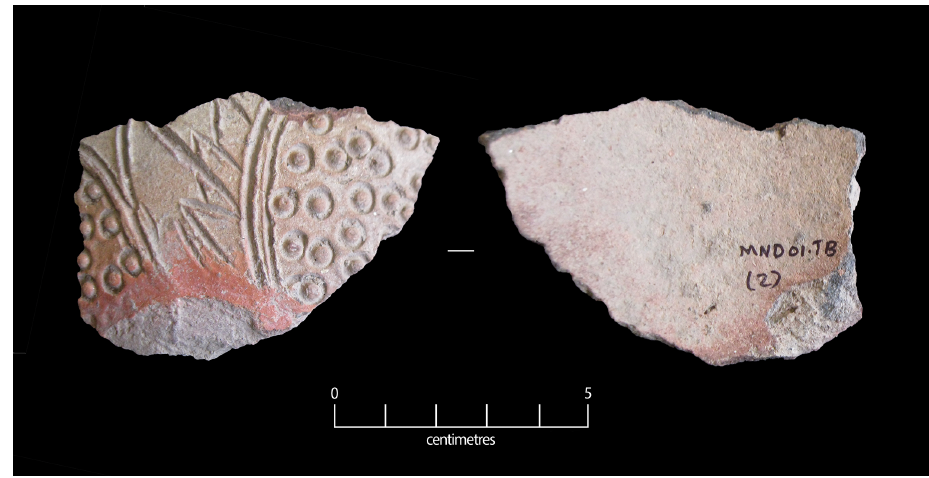
Figure 7: External and internal surfaces of a decorated Class 2 variant 4 body